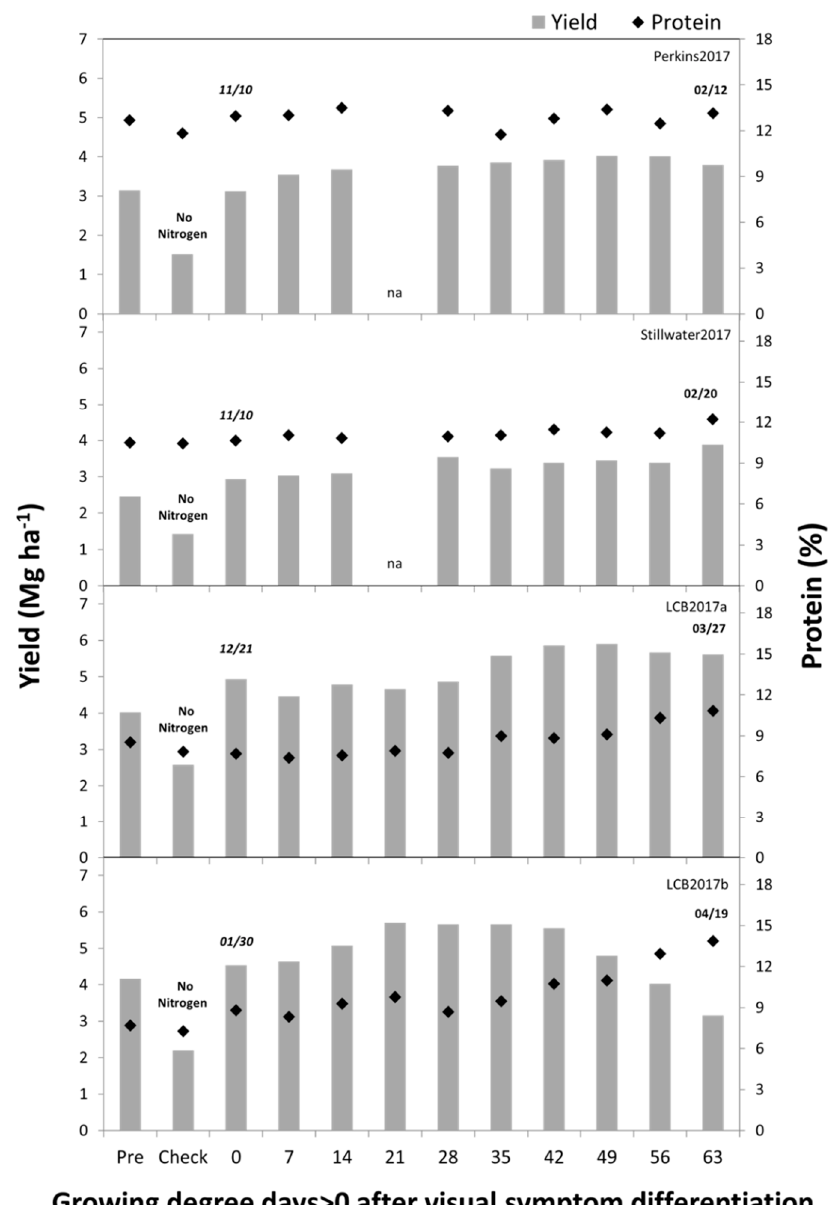
Figure 1. Winter wheat grain yield and protein response to the application of 100 kg N ha − 1 as affected by the timing of application at Perkins, Stillwater, Lake Carl Blackwell (a), and Lake Carl Blackwell (b) at Oklahoma in 2016–2017. The “a” and “b” demonstrates two different studies in the same year on the same location (LCB2017a and